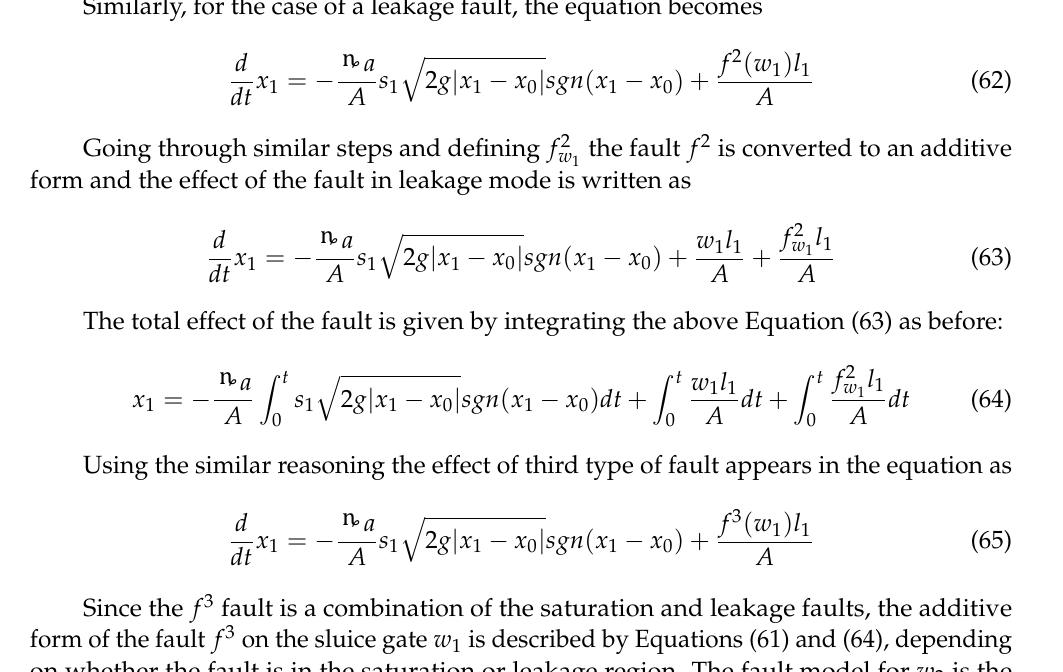
Figure 1. Three-pond hydraulic system.